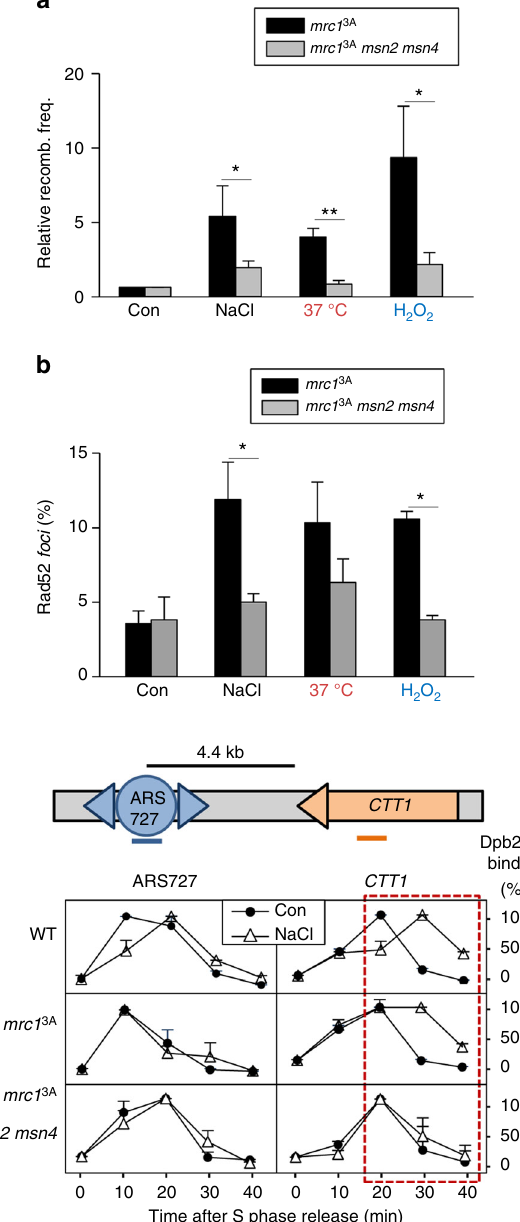
Fig. 3 Genomic instability in mrc1 3A cells depends on transcription. a Deletion of the MSN2 and MSN4 transcription factors suppresses the high TAR levels of the mrc1 3A strain upon stress. Numbers are relative to the recombination levels in control conditions. b The mrc1 3A msn2 msn4 strain displays fewer Rad52-YFP foci than the mrc1 3A strain upon